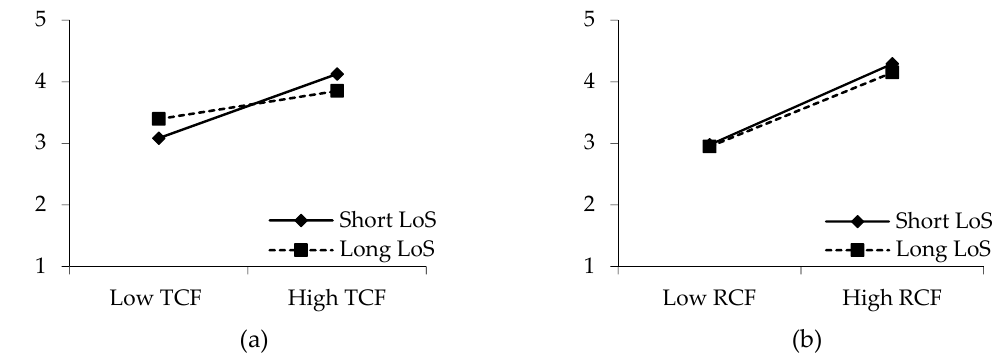
Figure 3. Moderating e ff ects of the length of joining in the company (LoS) between (a) transactional contract fulfillment (TCF) and organizational identification (OI) and (b) relational contract fulfillment (RCF) and organizational identification (OI).